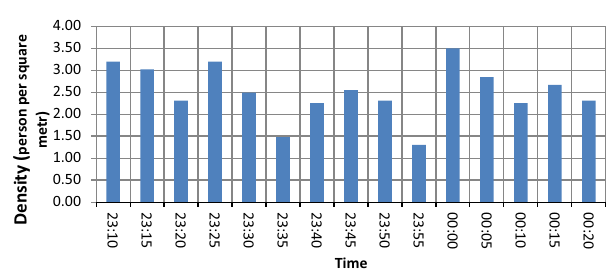
Table IV. Statistical analysis of speed data from tomb to the Al-Baqi